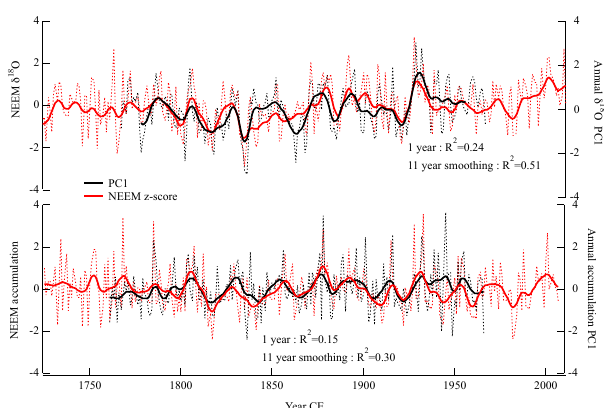
Figure 5. Top: comparison between NEEM δ 18 O z score (red, no unit) with the first principal component (PC1) of 16 Greenland an- nual δ 18 O records (Ortega et al., 2014) (black, no unit). Bottom: comparison between NEEM δ 18 O z score (red, no unit) with the first principal component (PC1) of 13 Greenland annual accumula- tion records (common with those used for δ 18 O) calculated using the same methodology as published for δ 18 O (black, no unit; see Fig. S1 in the Supplement). Annual mean data are shown as dot- ted lines, and 11-year binomial averages are shown as bold lines. We also report the respective coefficients of determination between the annual mean NEEM data and the PC1 ( p values are lower than 10 − 9